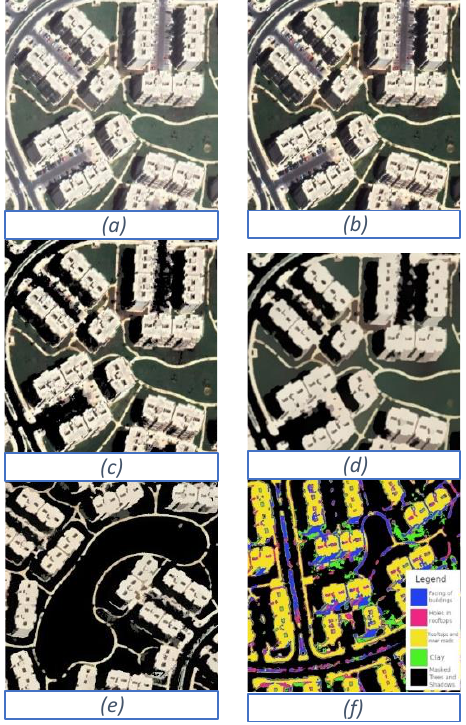
Figure 4 . Image enhancements and segmentation; (a) The original image, (b) Gamma correction, (c) Shadow masking,